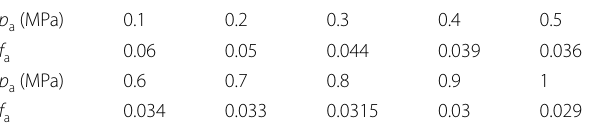
Table 1 Contact frictional coefficient at different pressures